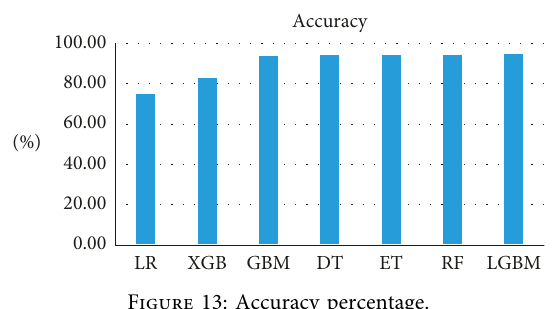
Figure 13: Accuracy percentage.